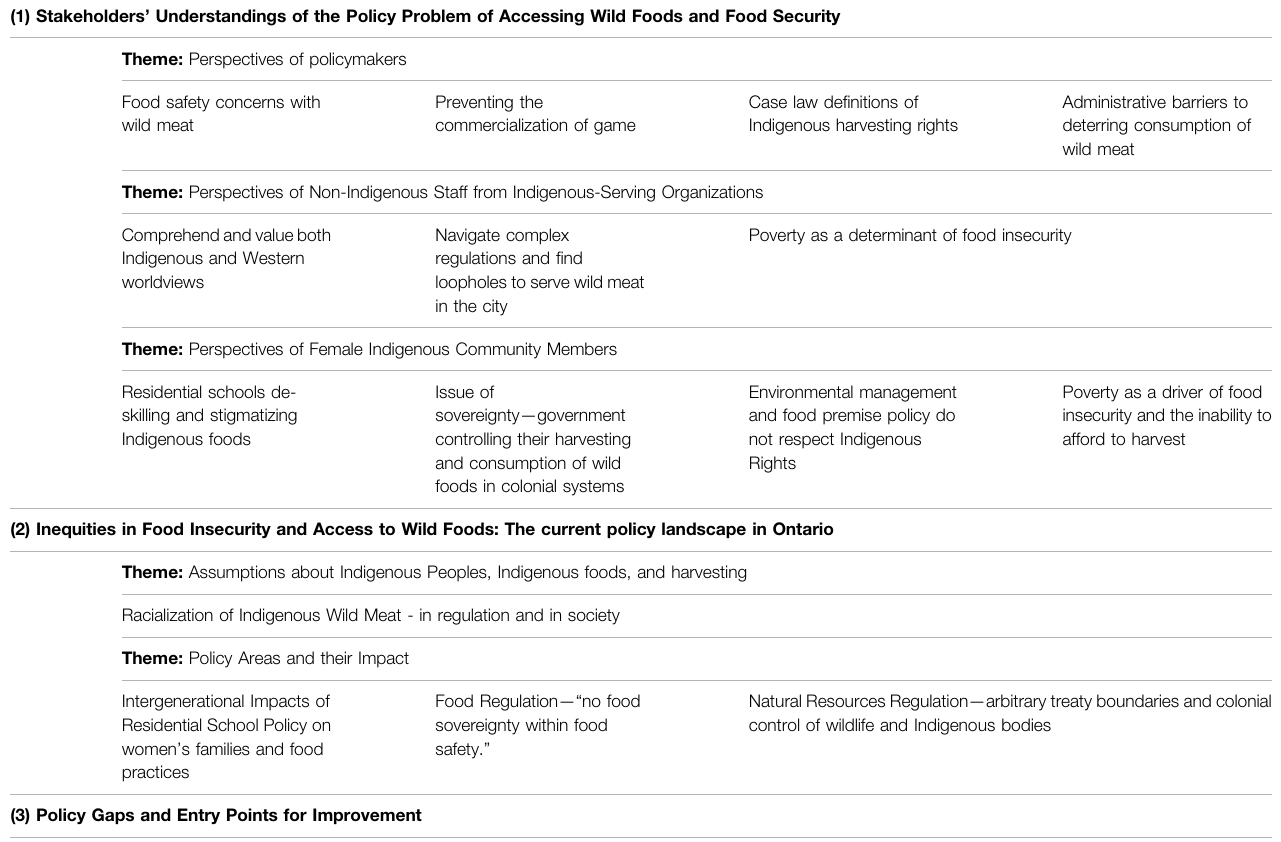
TABLE 1 | Summary of fi ndings: Themes and subthemes by research question.